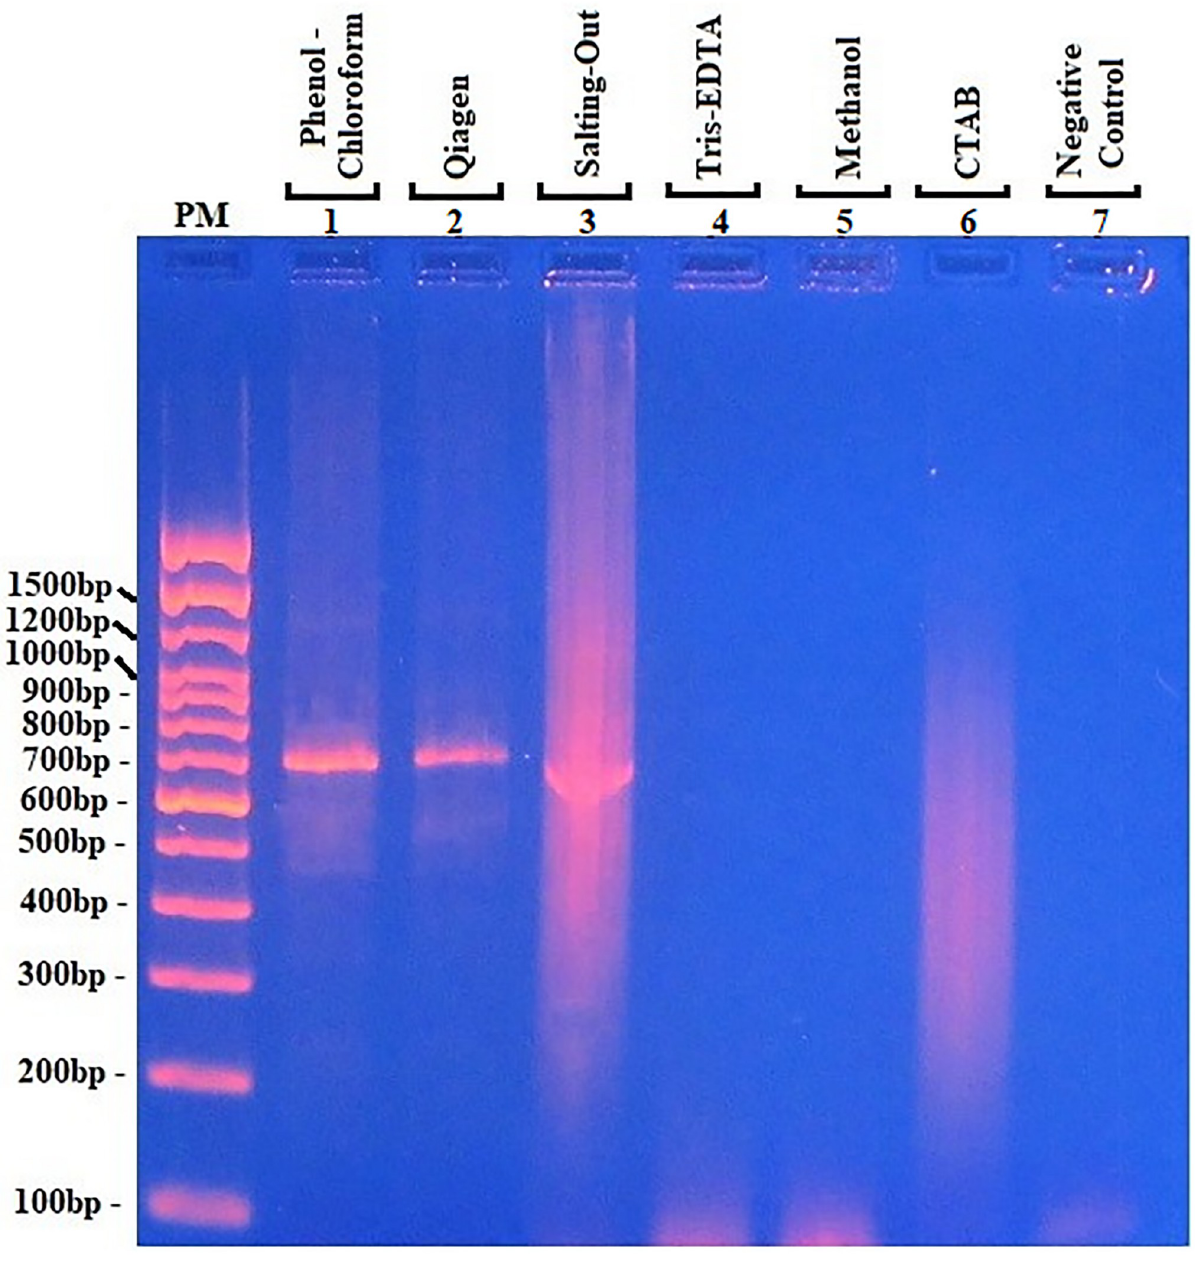
Fig 3. Amplification of DNA extracted by PCR. Comparison of amplicon obtained after amplification of Loa loa DNA extracted with the six methods as template. The primers were designed from the Brugia ALT1 gene. Results of the analysis of amplicons after agarose gel electrophoresis (1.5%) and visualization under UV light. The methods are listed on the top of each band: phenol:chlorof line 1; Qiagen line 2; salting out line 3; Tris-EDTA line 4; Methanol line 5; CTAB line 6; band 7 is a negative control. PM = molecular marker. The values on the left represent the size of DNA.